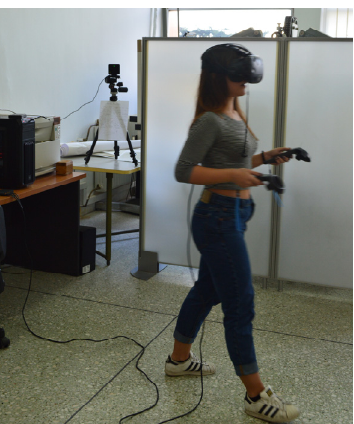
Figure 11: The visitor walks in the physical space and virtually explores the underwater remains.